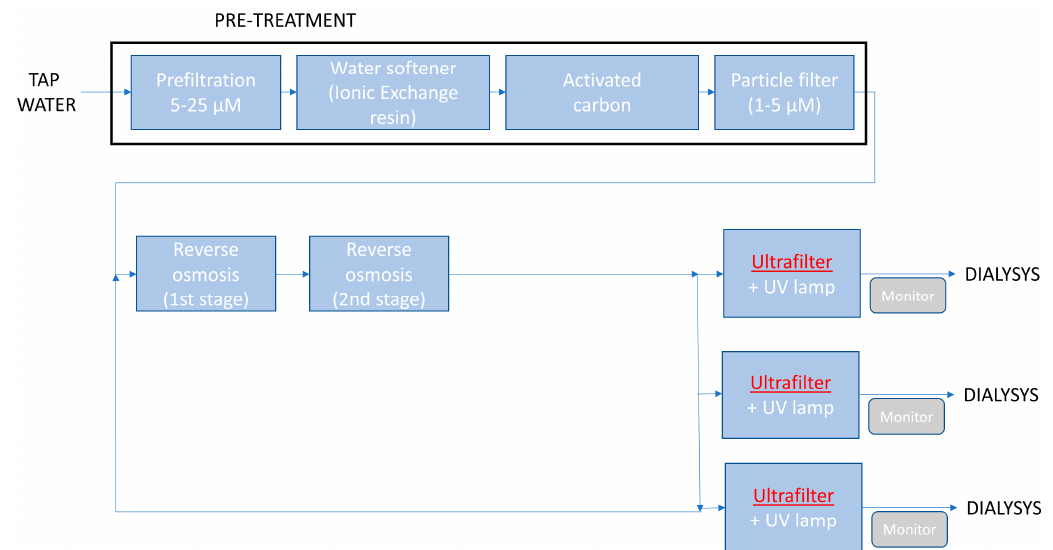
Figure 1. Water treatment diagram. Pretreatment should achieve the highest possible elimination of particles, the disappearance of chloramines and other organic matter and a decrease of the number of cations. The first element is a sand and anthracite filter, followed by additional filters, a double descaler by exchange resins; and two activated carbon filters. Carbon filters eliminate chloramine and chlorine from dialysate. Pretreated water then passes through reverse osmosis columns. Ultrafilters are highlighted in red, where contamination was found in the present report. Ultrafilters are the last safety feature before dialysate infusion and prevent compounds leaked from previous steps to reach the dialyzer.